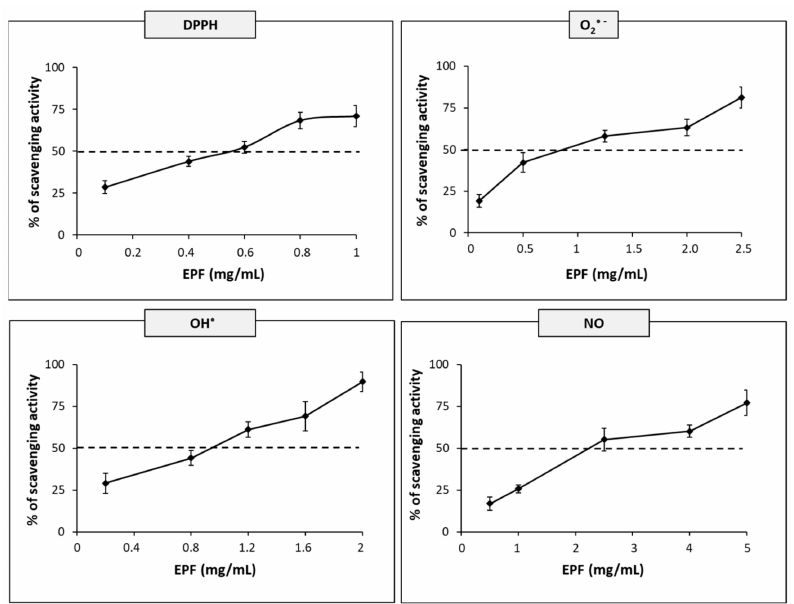
Figure 2. Scavenging activities of the enriched polysaccharide fraction from P. eryngii . The graphs represent the scavenging activities of the enriched polysaccharide fraction (EPF) against, 2,2-diphenyl- 1-picrylhydrazyl (DPPH), superoxide radical (O 2 - • ), hydroxyl radical (OH • ) and nitric oxide (NO).